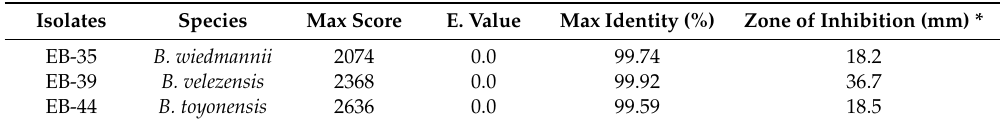
Table 2. Primary screening of endophytic bacteria by Xcc W1.